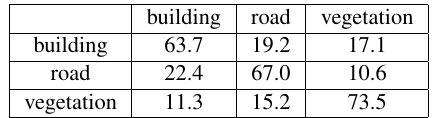
Table 3: The confusion matrix: pixelwise accuracy of the stan- dard CRF classification on the Beijing Airborne Data.